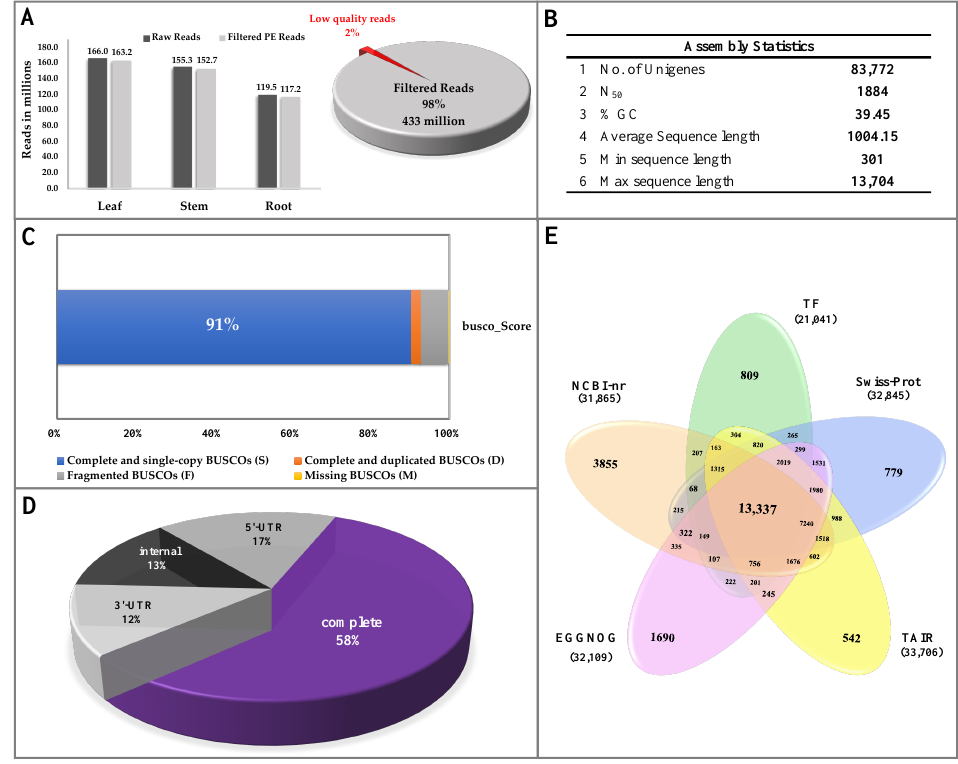
Figure 2. Global details of total sequenced reads of I. racemosa generated from illumina NovaSeq 6000 platform. ( A ) Quality filtering of sequenced reads. ( B ) Assembly statistics. ( C ) BUSCO score of assembled unigenes. ( D ) Open reading frame prediction in de novo assembled sequence representing 58% of complete coding region. ( E ) Venn diagram illustrating annotation of unigenes with five public protein